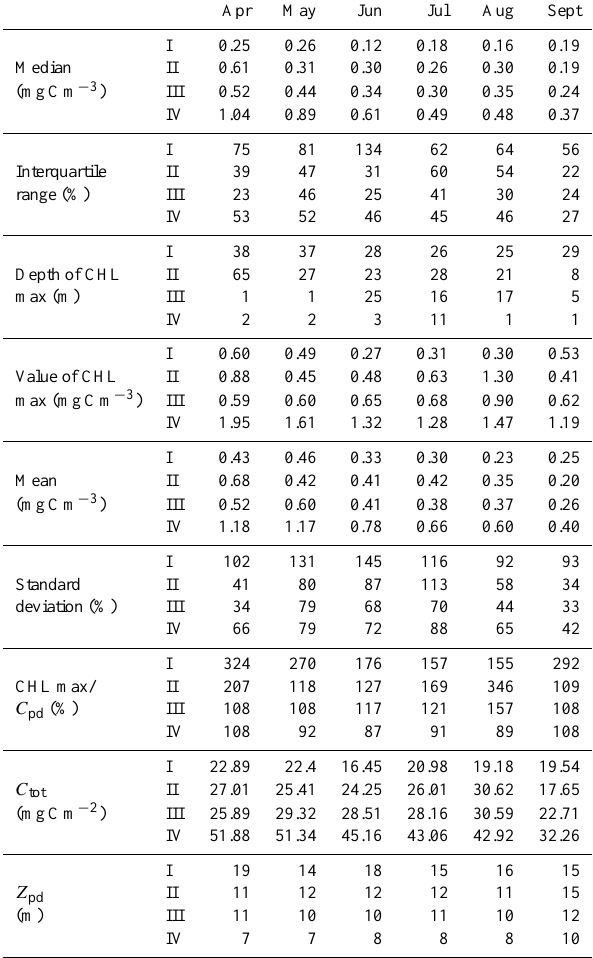
Table 1. Characteristics of the chlorophyll profiles categorized ac- cording to the mean chlorophyll in the surface layer ( C pd ) , and then binned into monthly bins. Roman numerals indicate the four ranges of C pd (mgCm − 3 ): (I) < 0.3; (II) 0.3–0.45; (III) 0.45–0.7; (IV) > 0.7. C tot is the total chlorophyll content in the water column, and Z pd is the penetration depth (also known as the first optical depth). The median, mean, inter-quartile range, and standard deviation are averaged for the whole water